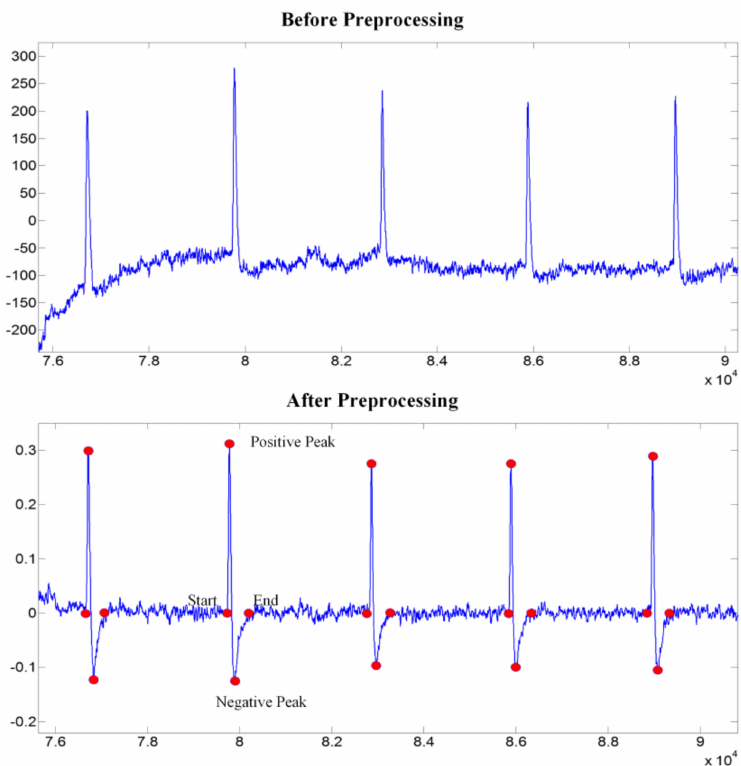
Figure 6. The contrast of before and after preprocessing of the eye blinking signals.